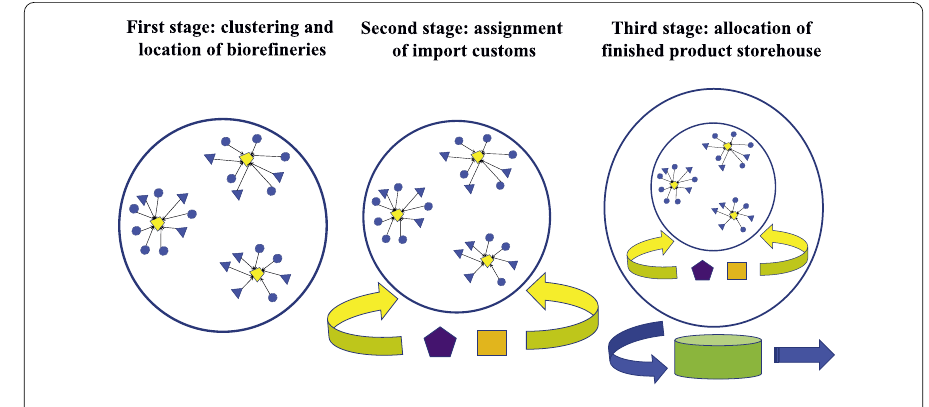
Figure 2 The three stages of construction of the